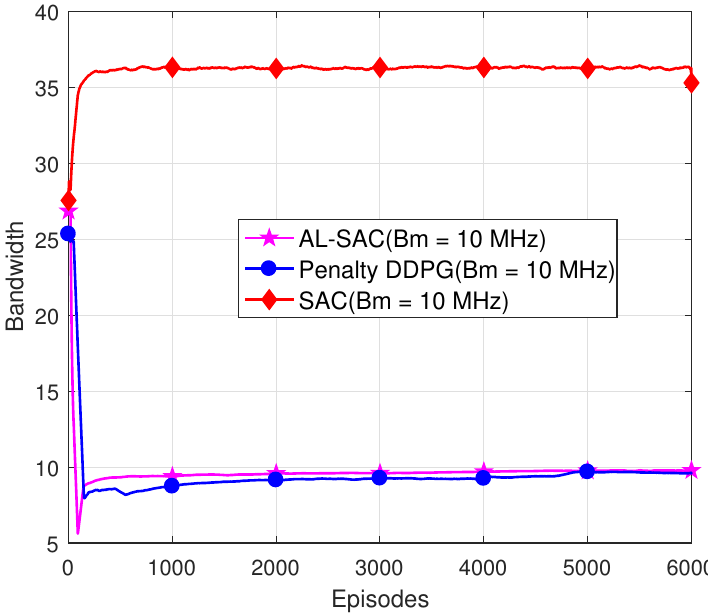
Figure 7. The total bandwidth allocated by different